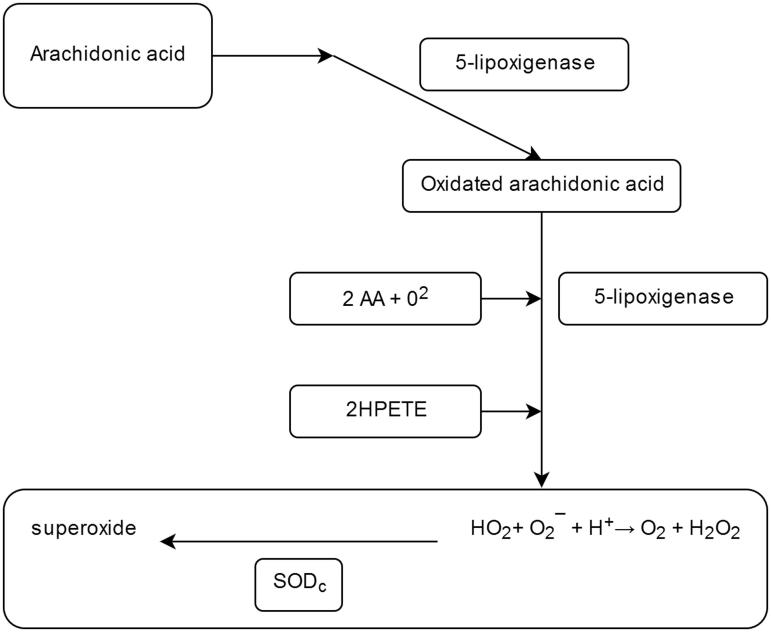
Production of ROS – the role of superoxide dismutase (SODc) as an antioxidant agent17.